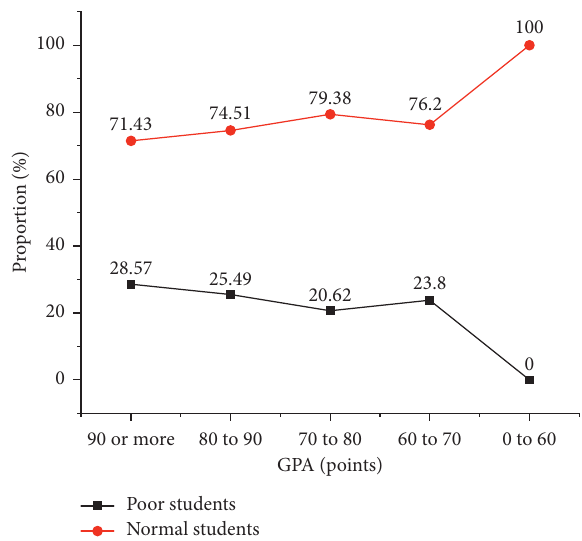
Figure 4: Proportion of poor students in different score ranges.